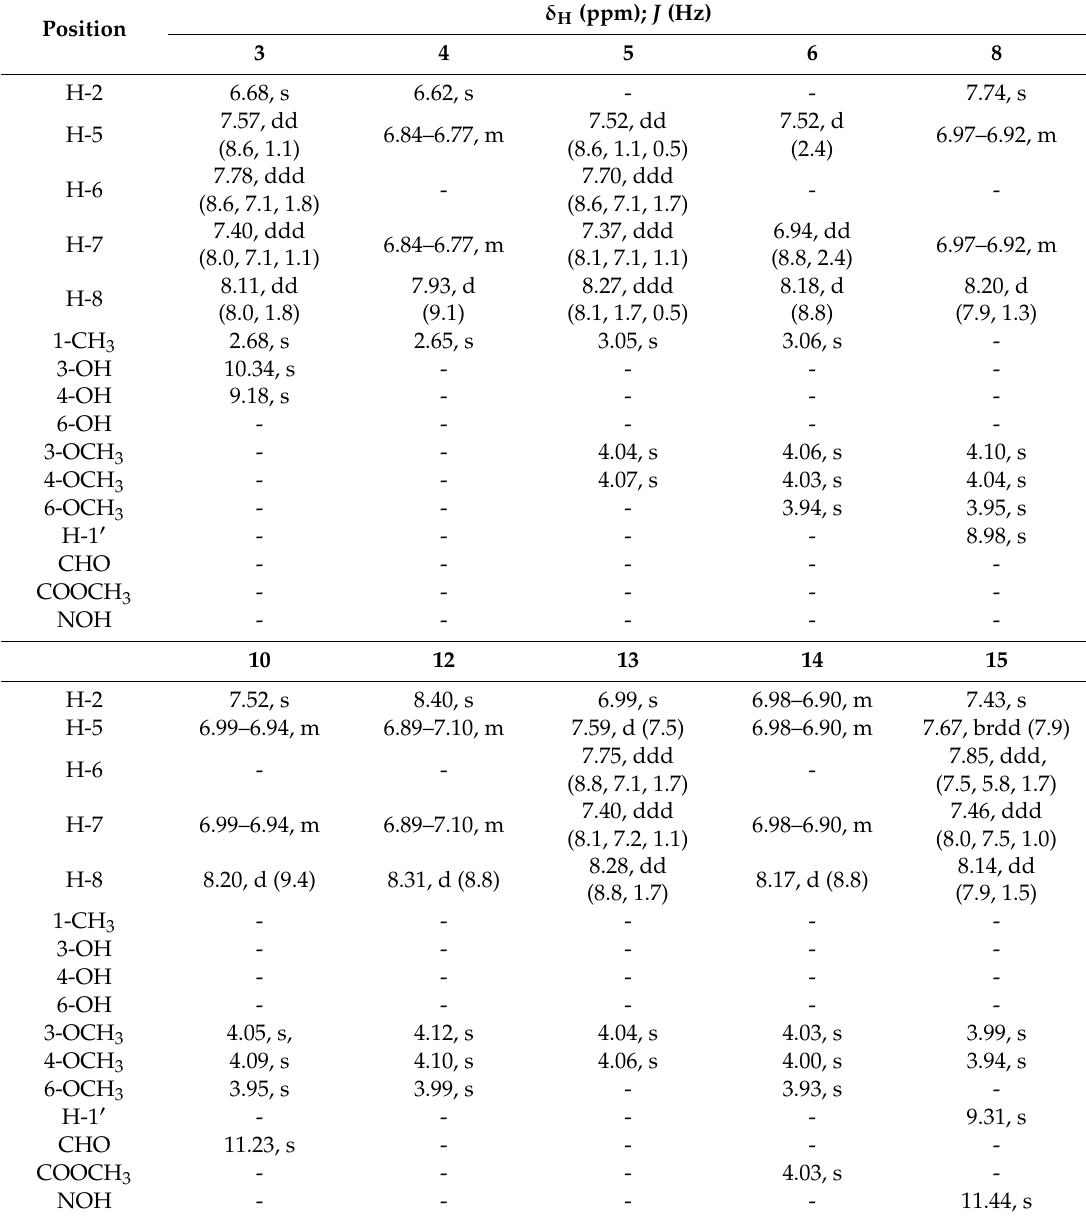
Table 1. 1 H-NMR data (300 MHz, CDCl 3 ) for 3 – 6 , 8 , 10 – 15